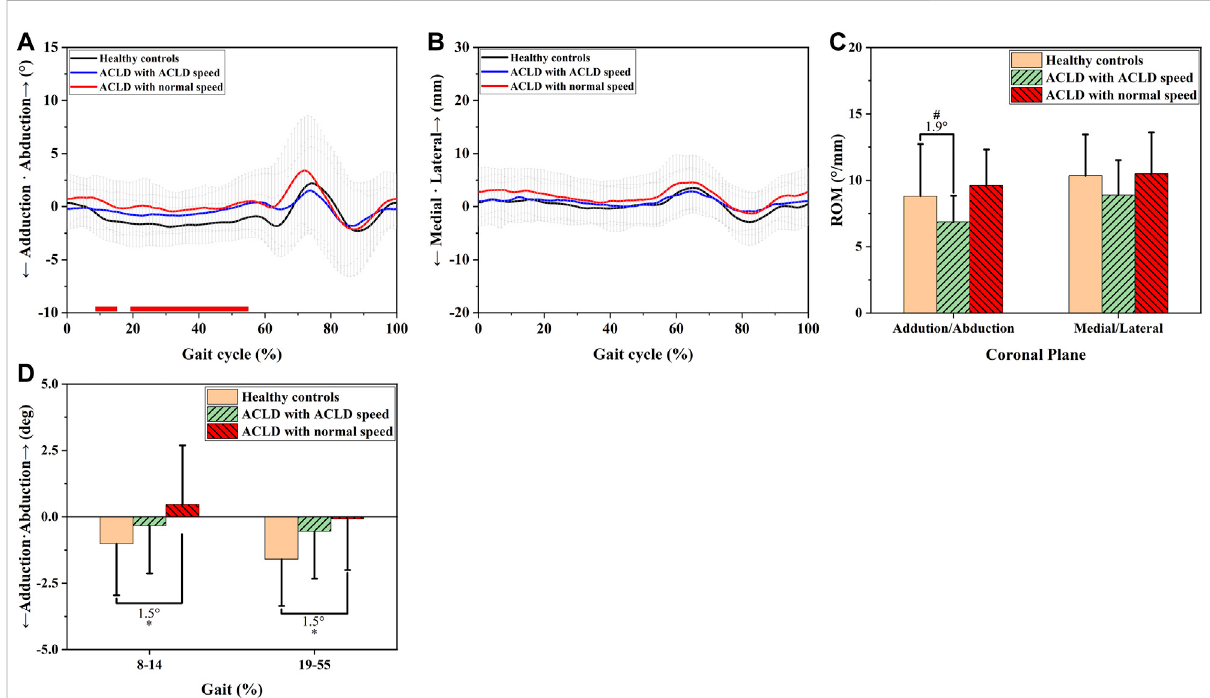
FIGURE 3 Coronal knee kinematic alterations of healthy controls and ACLD patients during gait. Chart (A,D) show walking adduction/abduction angle alterations of ACLD patients at ACLD speed and the speed level of healthy controls (normal speed) compared to healthy controls. Chart (B) shows walking medial/lateral tibial translationalterations ofACLD patients atACLD speed and thespeed level ofhealthy controls (normalspeed) compared to healthy controls. Chart (C) shows the range of motion of adduction/abduction angle and medial/lateral tibial translation of ACLD patients comparedtohealthycontrolsduringwalking.#Signi fi cantkinematicdifferenceswerefoundinACLDpatientswhowalkedatACLDspeedcompared to healthy controls. *Signi fi cant kinematic differences werefound inACLD patients whowalked atthesame speed levelas healthycontrols (Normal speed) compared to healthy